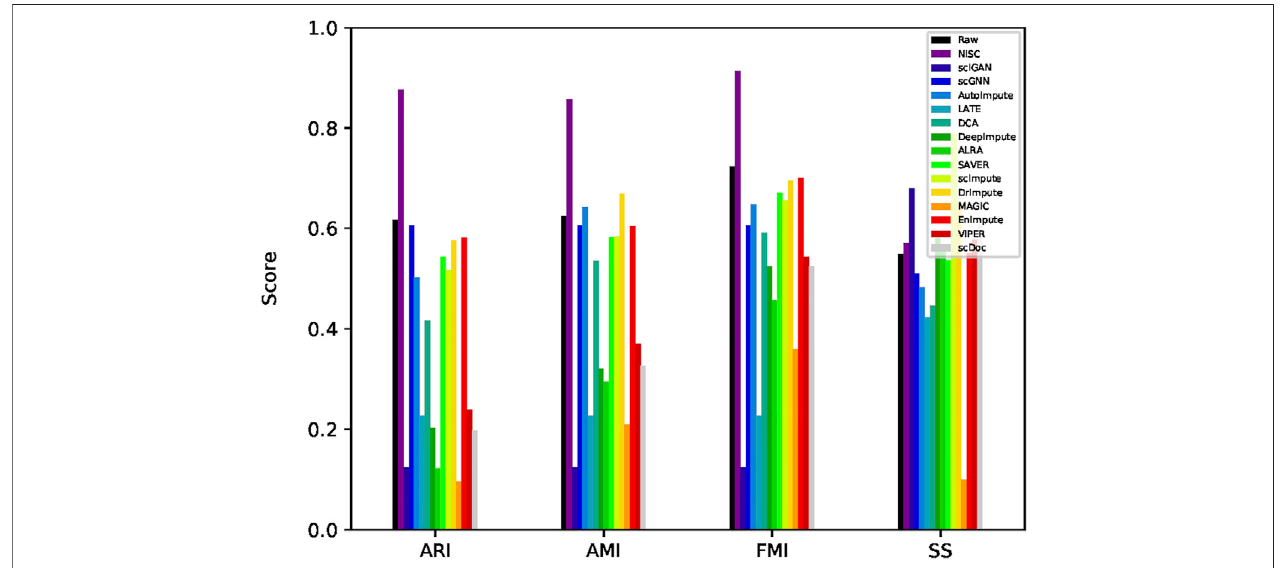
FIGURE 7 | Evaluation of clustering accuracy on the mouse lung data. Four measurements, AMI, ARI, FMI, and SS, are calculated for the imputed and raw data. The de fi nitions of the measurements can be found in the supplementary materials.